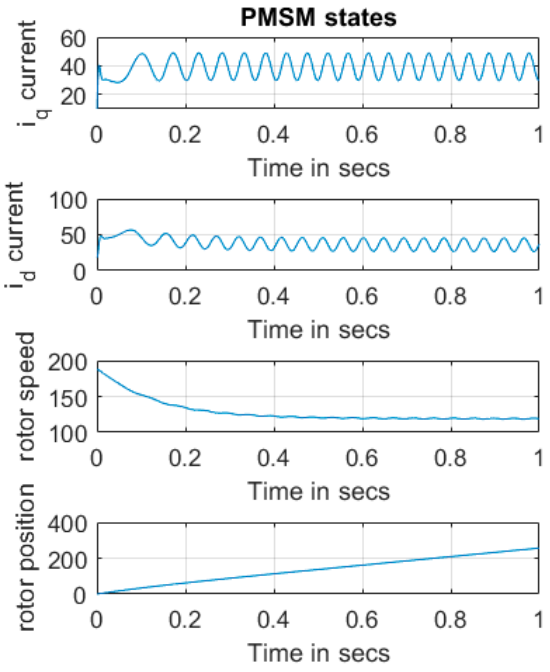
Figure 1. Variation of the permanent magnet synchronous motor (PMSM) characteristics as a function of time over the timeframe of 1 s at normal room temperature.